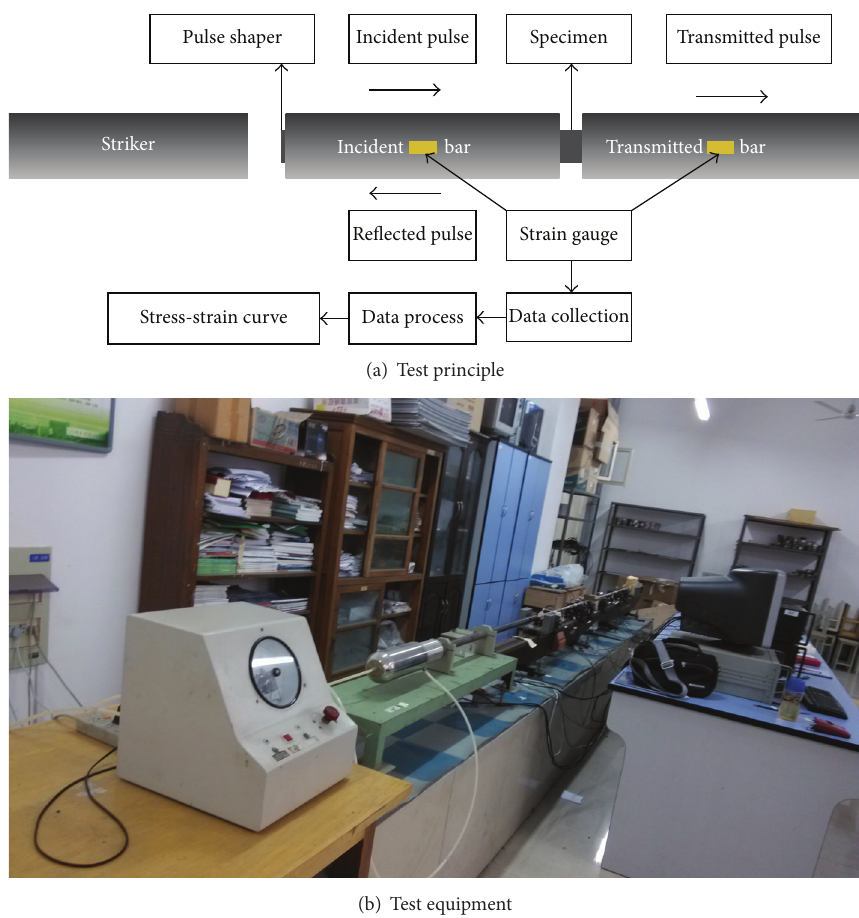
Figure 1: Test equipment and